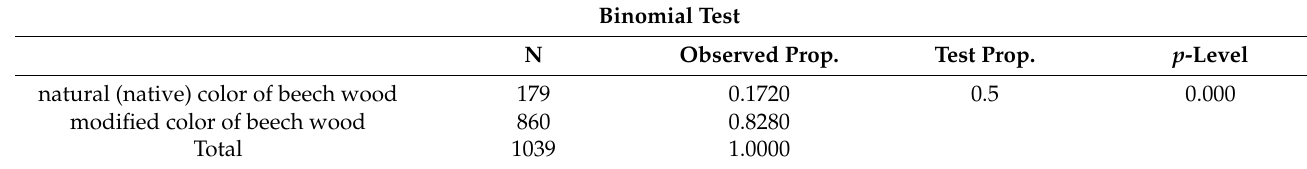
Table 5. Binomial test results for Hypothesis H2.